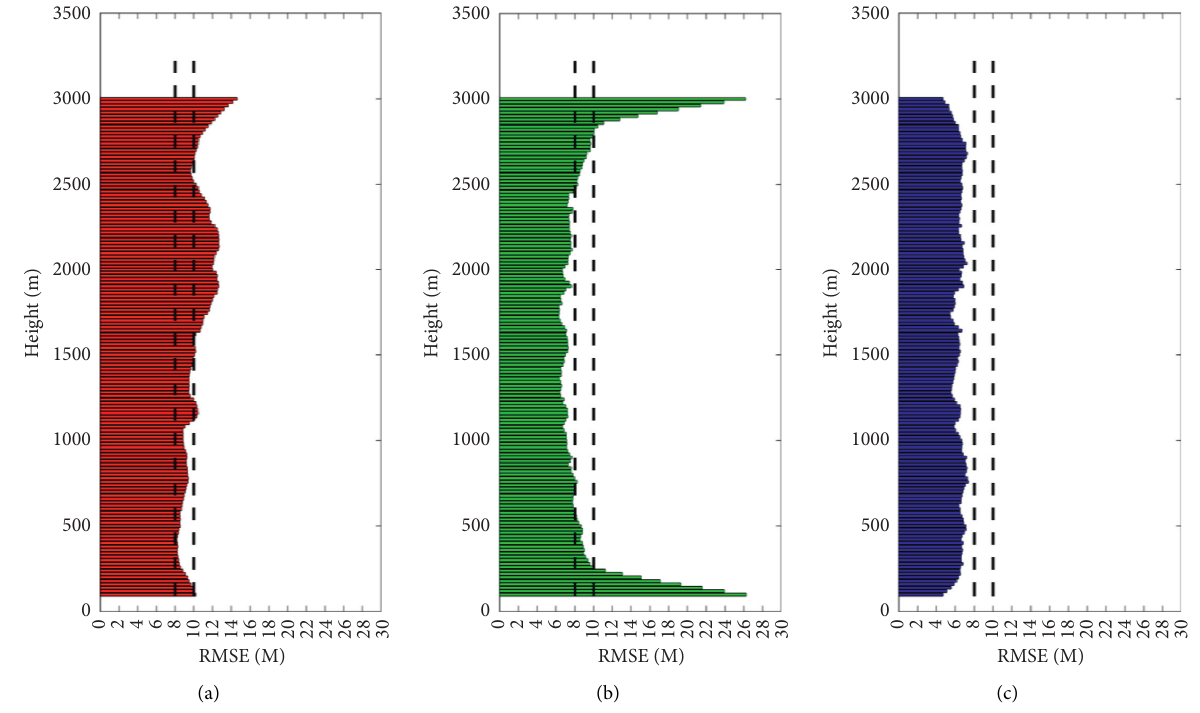
Figure 5: The average RMSE of the three algorithms at each height.